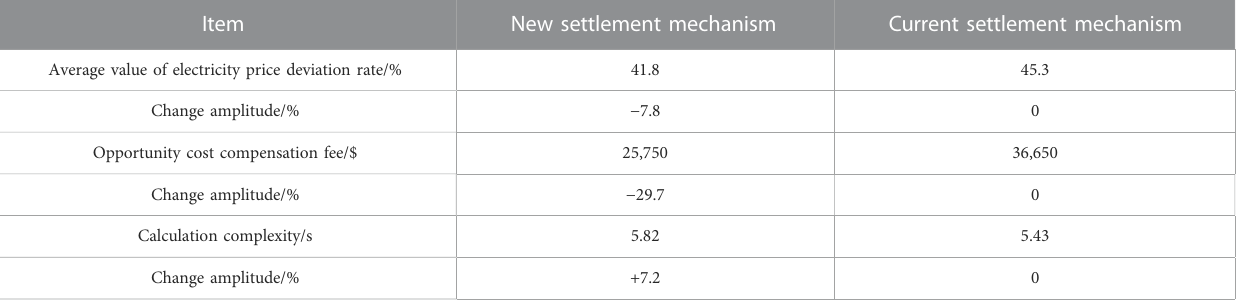
TABLE 3 The incentive of fi rst-settlement